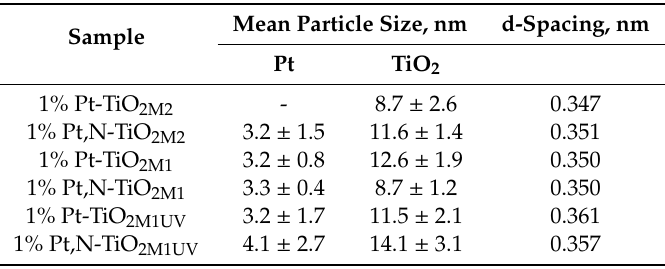
Figure 9. TEM images and electron diffraction patterns: ( a ) 1% Pt-TiO 2M2 ; ( b ) 1% Pt,N-TiO 2M2 ; ( c ) 1% Pt-TiO 2M1 ; ( d ) 1% Pt,N-TiO 2M1 ; ( e ) 1% Pt-TiO 2M1UV ; ( f ) 1% Pt-N-TiO 2M1UV . Pt 0 nanoparticles (NPs) are indicated by the arrows. Table 5. Mean particle sizes and d-spacing obtained from TEM.